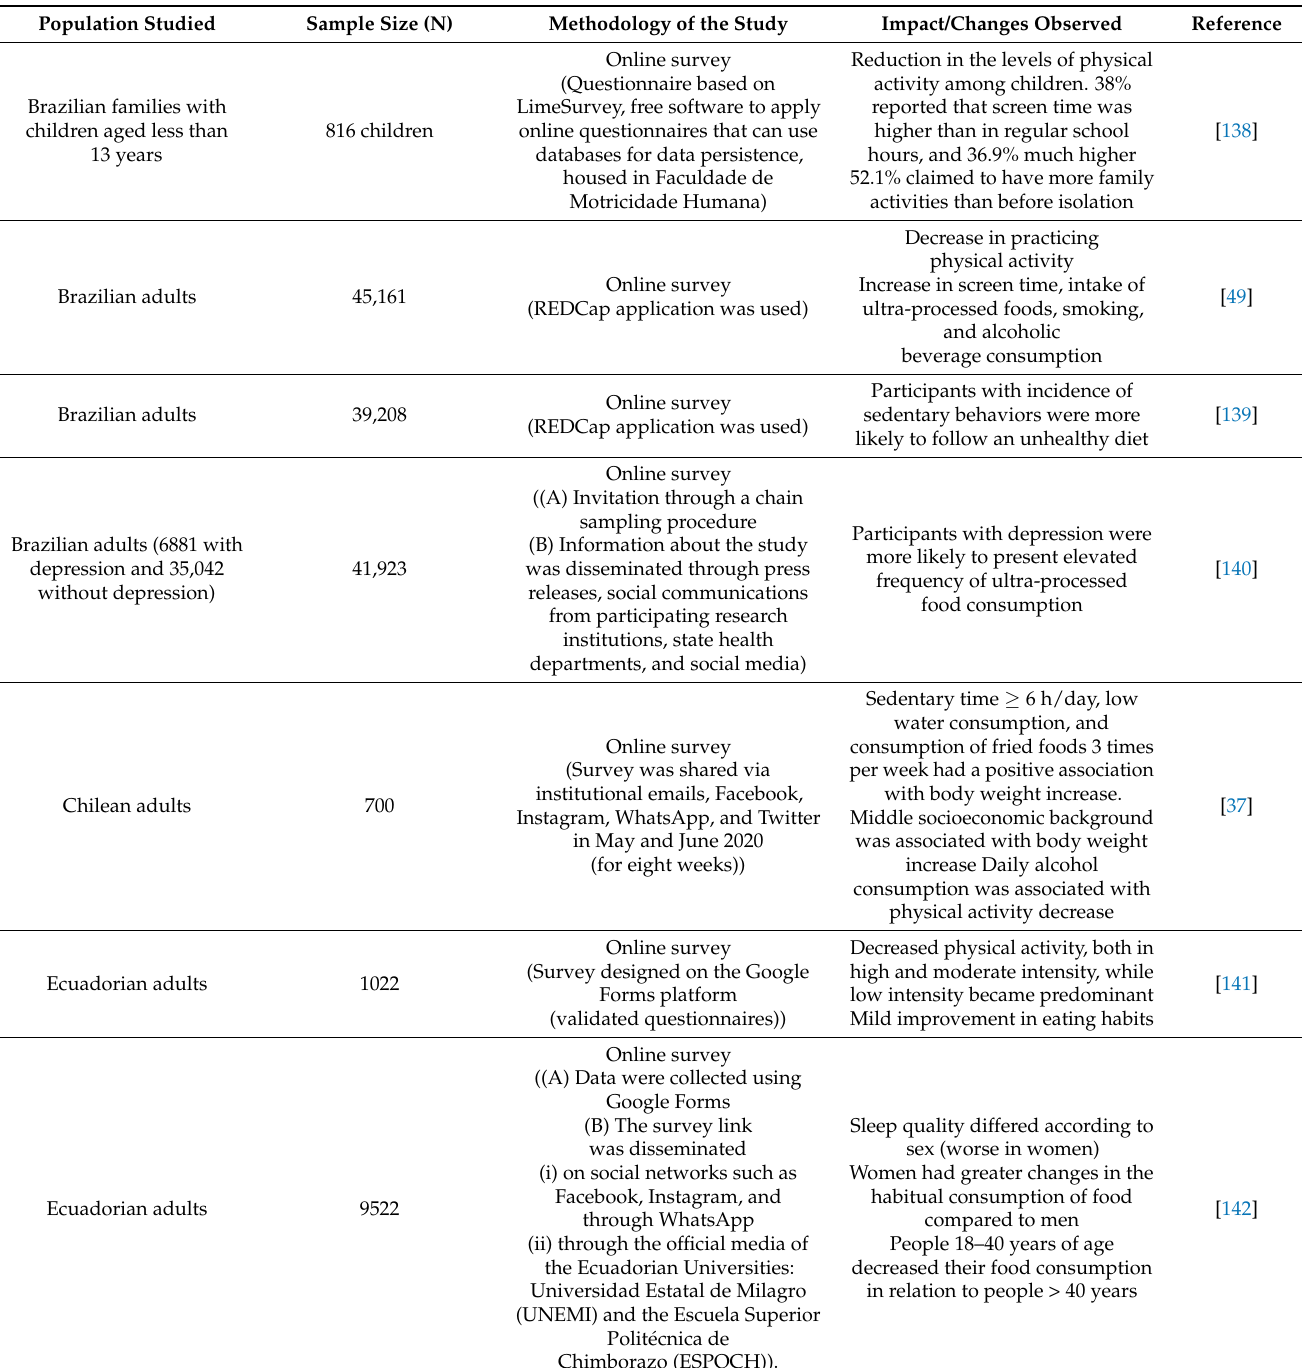
Table 5. Brief summary of studies related to the consequences of the lockdown in South American